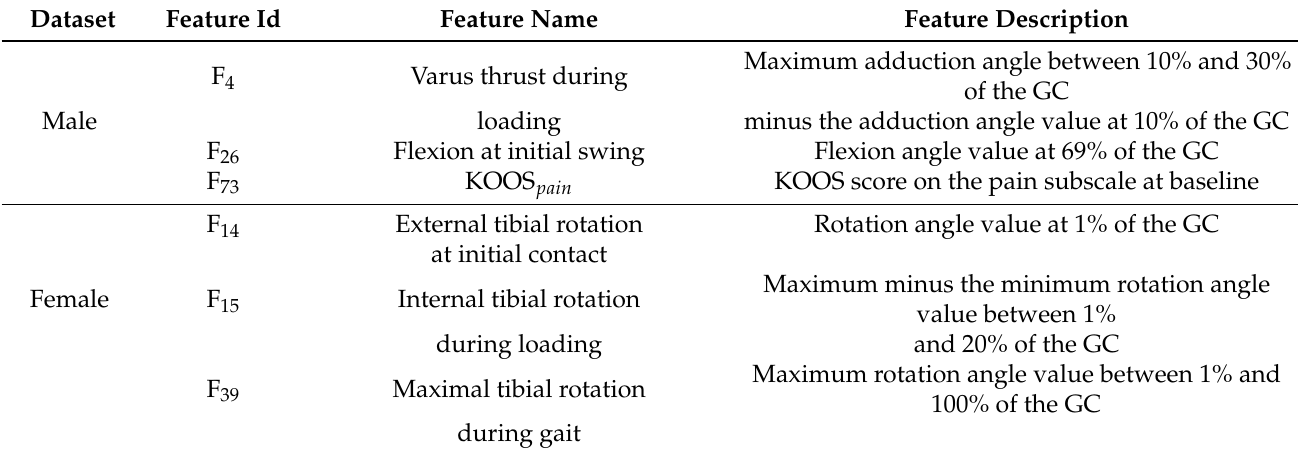
Table 8. Description of the retained features. All features (except for KOOS pain ) are expressed in